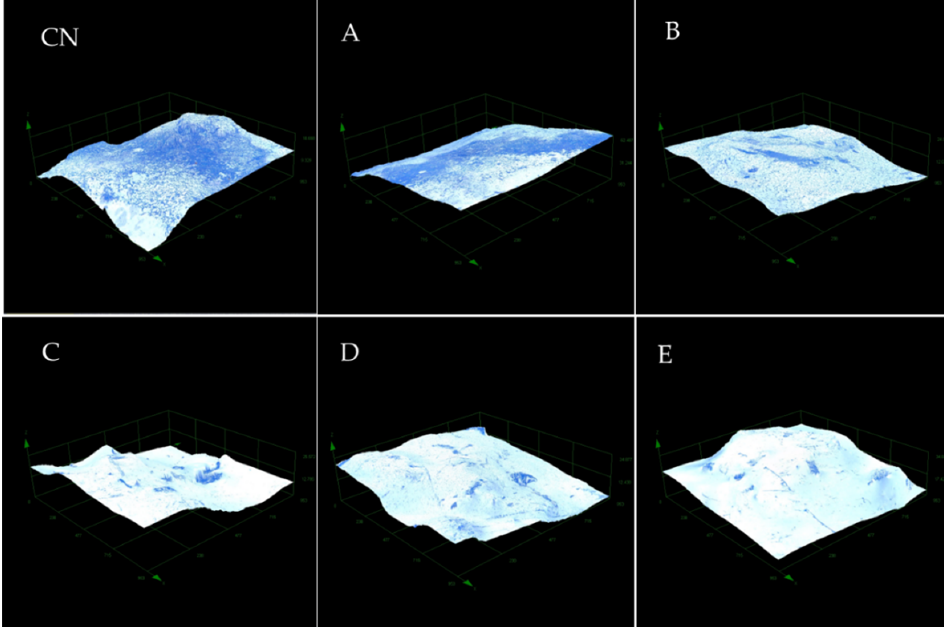
Figure 4. The 3 ‐ dimensional images of ceramic tile surface with formed 24 h A. baumannii ATCC Figure 4. The 3-dimensional images of ceramic tile surface with formed 24 h A. baumannii ATCC